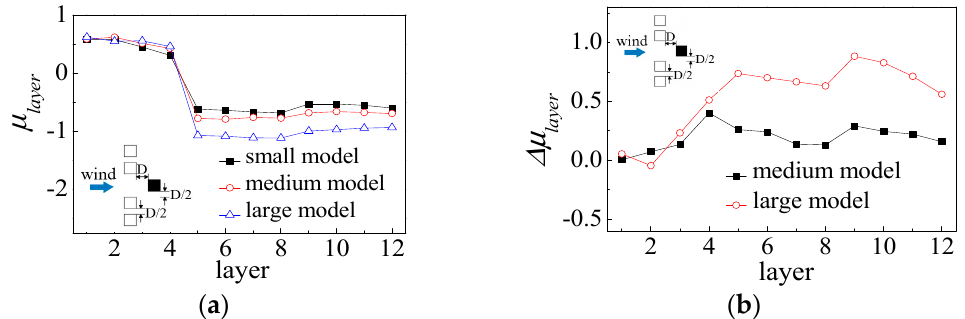
Figure 10. The wind tunnel test results of test condition 6. ( a ) Layer pressure coefficient; ( b ) relative error of layer pressure coefficient.